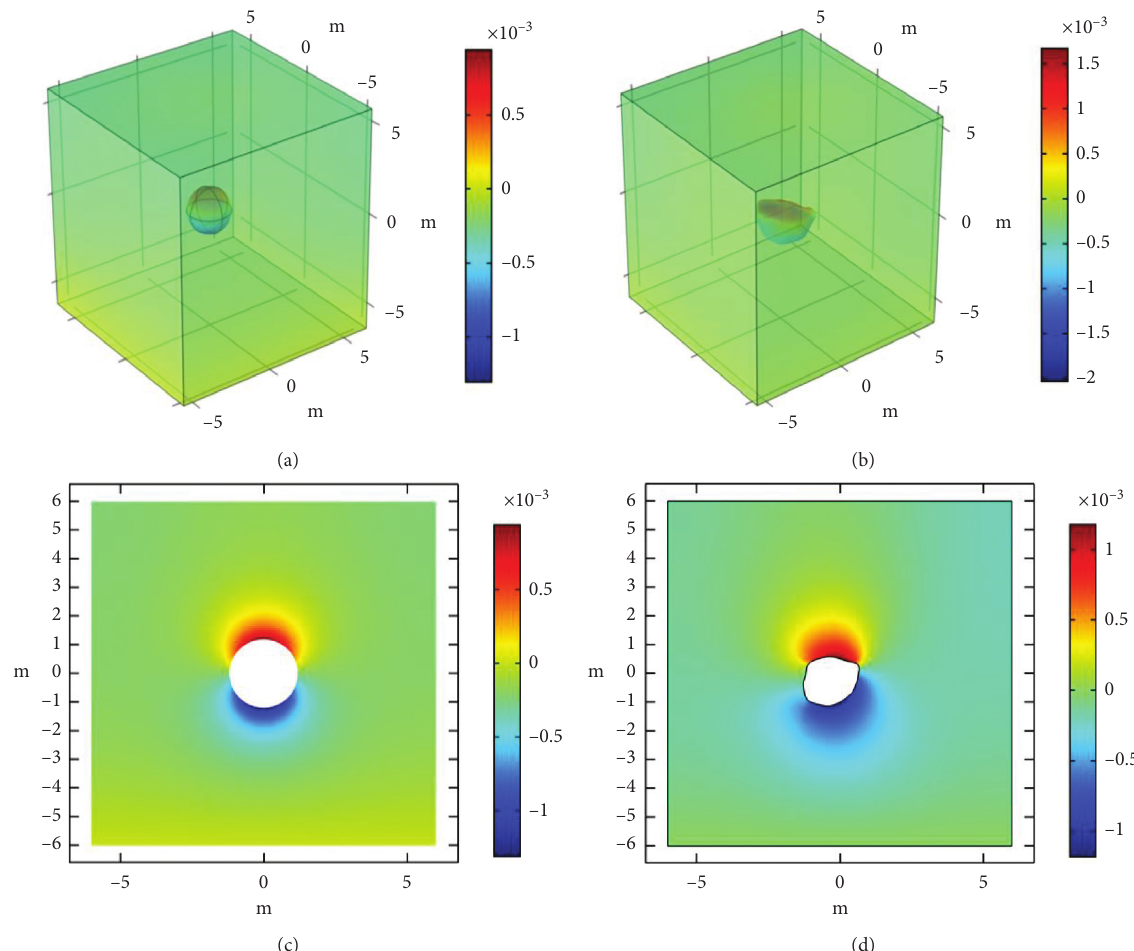
Figure 12: Vertical displacement field of: (a) 3D profile using sphere model; (b) 3D profile using sphere-like model; (c) 2D profile using sphere model; (d) 2D profile using sphere-like